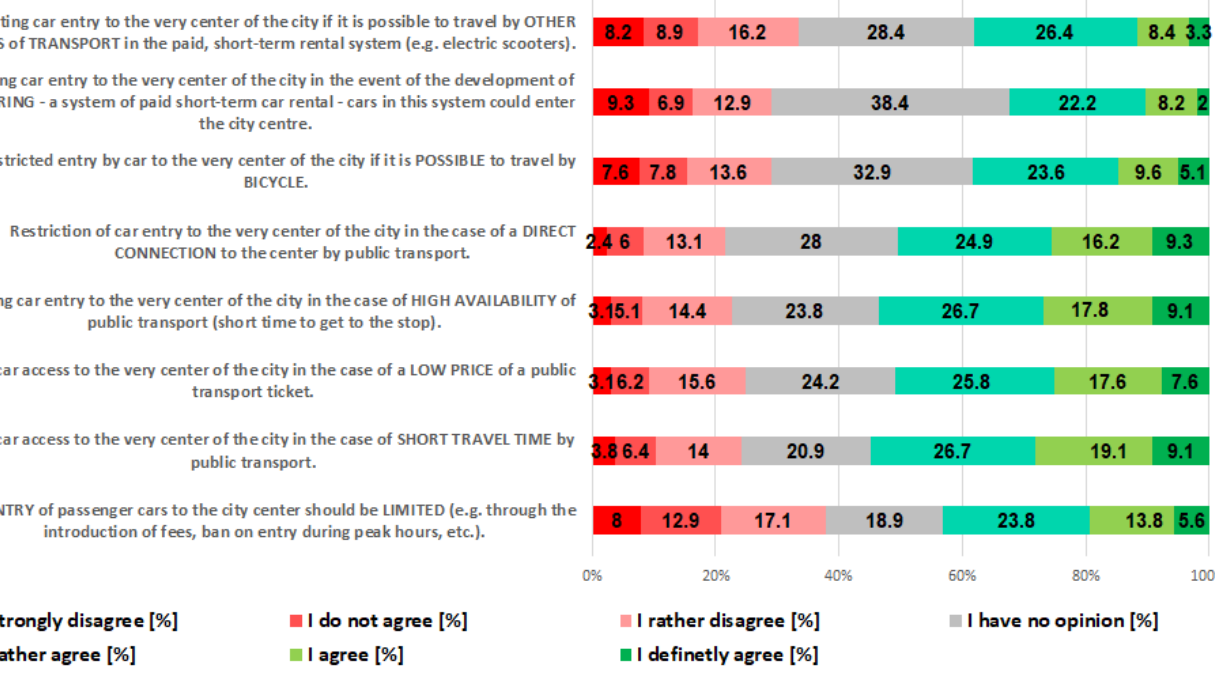
Figure 5. Evaluation of complex instruments for changing the mobility model. Source: based on [3].